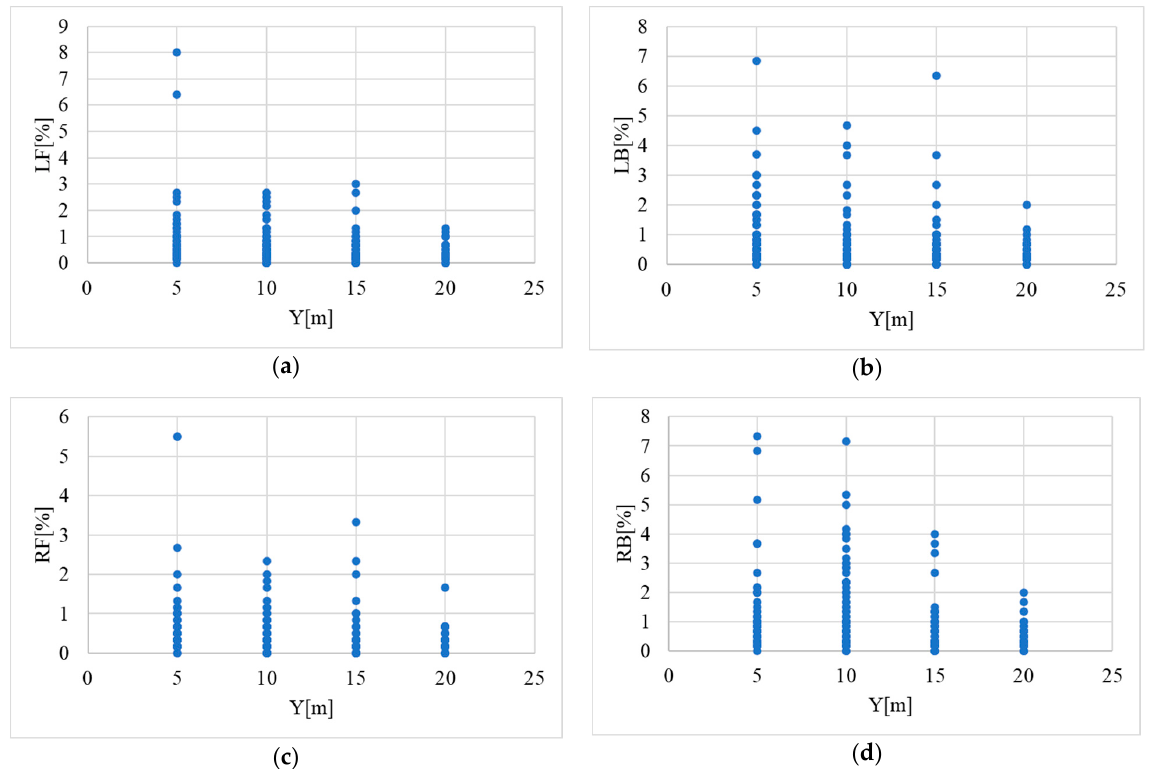
Figure 14. Relations between the number of lost data packets from Anchors: ( a ) LF, ( b ) RF, ( c ) LB, ( d ) RB, and the Y tag coordinate.